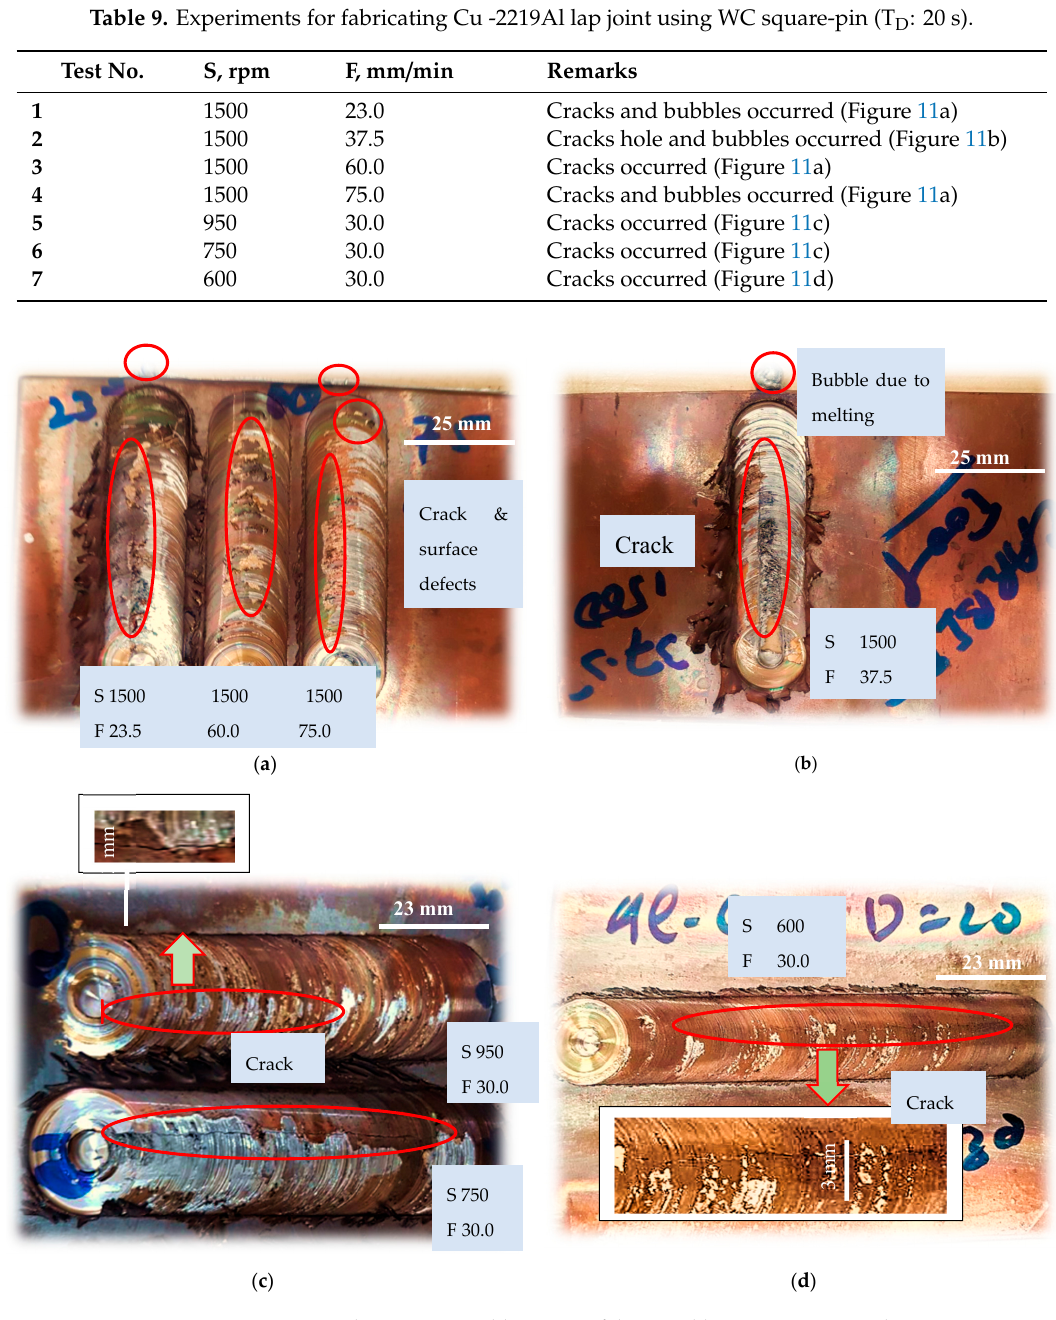
Figure 11. Dissimilar Cu-2219 Al lap joints fabricated by WC square-tool.